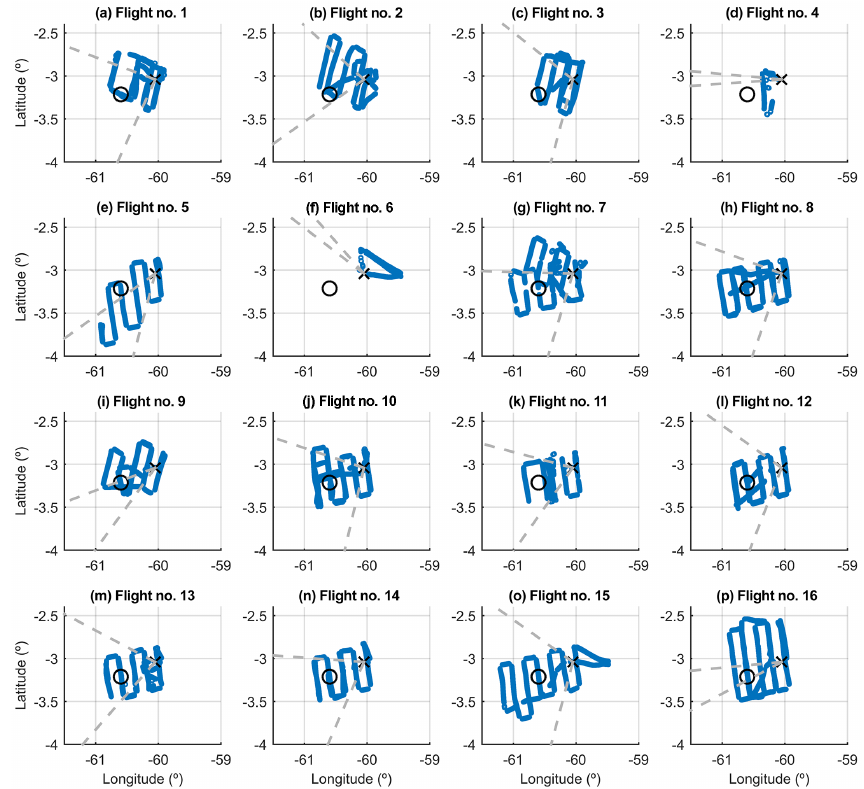
Figure 2. Trajectories for all G-1 flights during GoAmazon2014/5 IOP1. Manaus is located close to the {− 60 , − 3 } point, marked with an “X”, while the T3 site is marked with the black